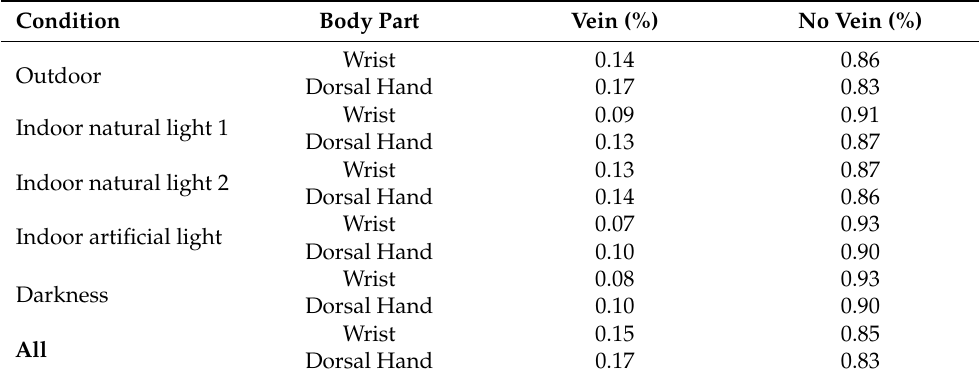
Table 3. SIFT keypoints matched in genuine samples located in vein and no-vein